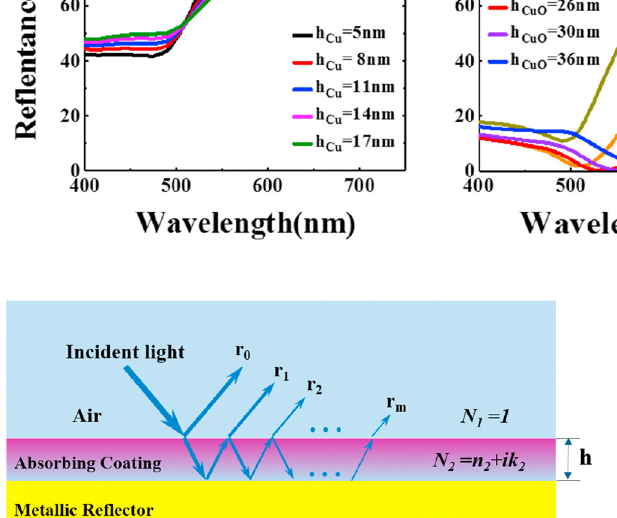
Figure 2: Reflectance spectra of a series of samples at normal incidence. (A) The experimentalreflectancespectraofaseries